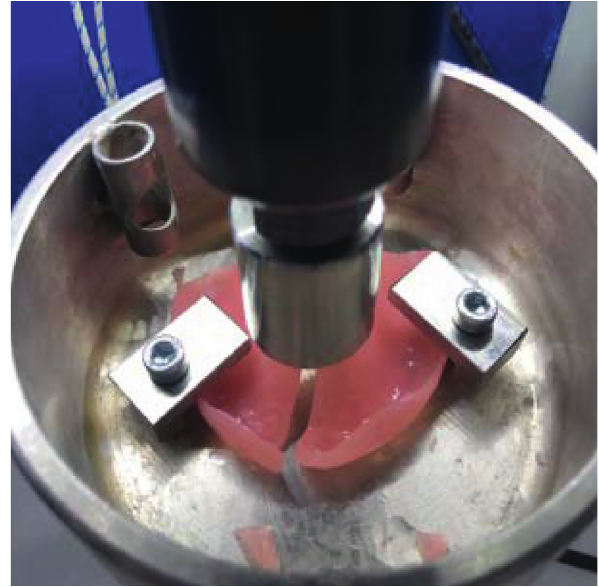
Figure 10: Prosthesis base fracture.